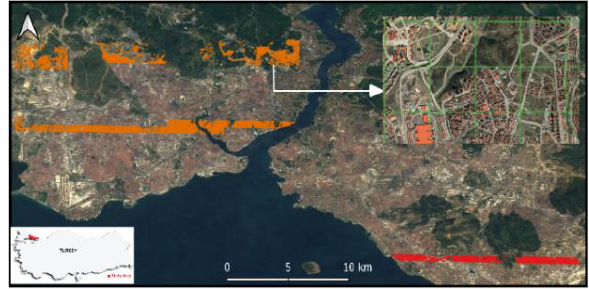
Figure 1 . CSCRS Istanbul Building